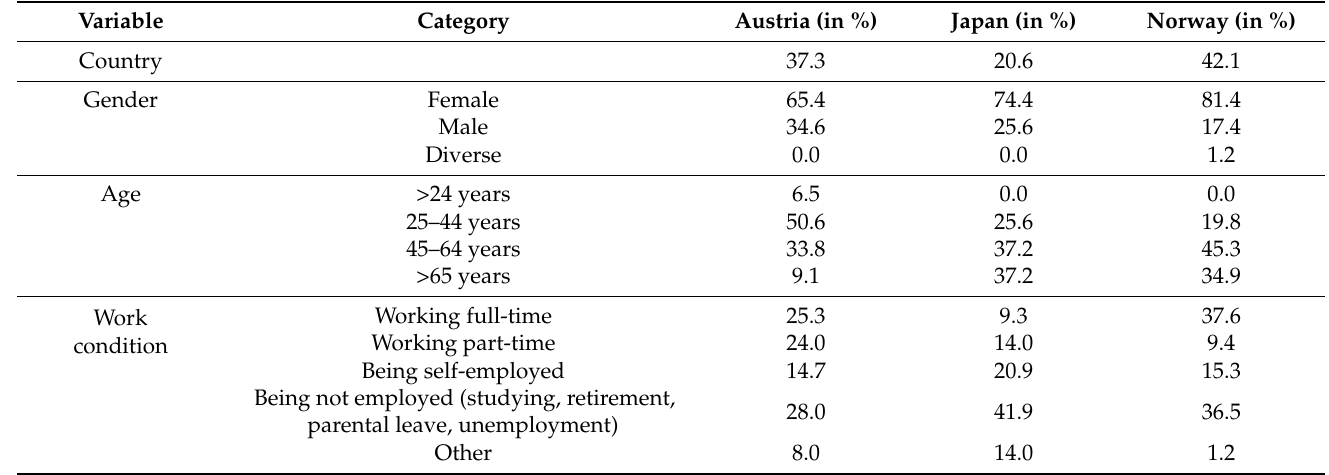
Table 2. Demographic characteristics of